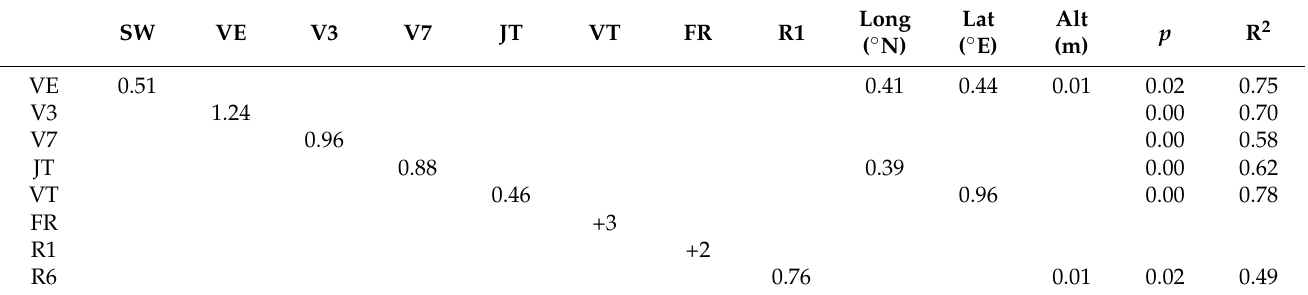
Table 2. Interpolation and reconstruction models for each phenological stage of maize, except for the sowing